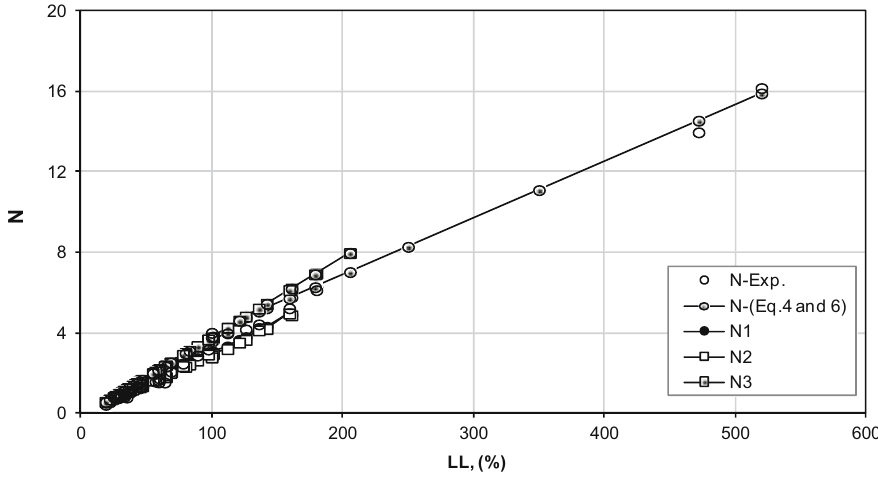
Figure 9: The comparison between the new Eqs. ( 4 ) – ( 6 ) of N vs complete range of LL and the other previous empirical equations in Table 1 for the given 59 di ff erent soils used in this